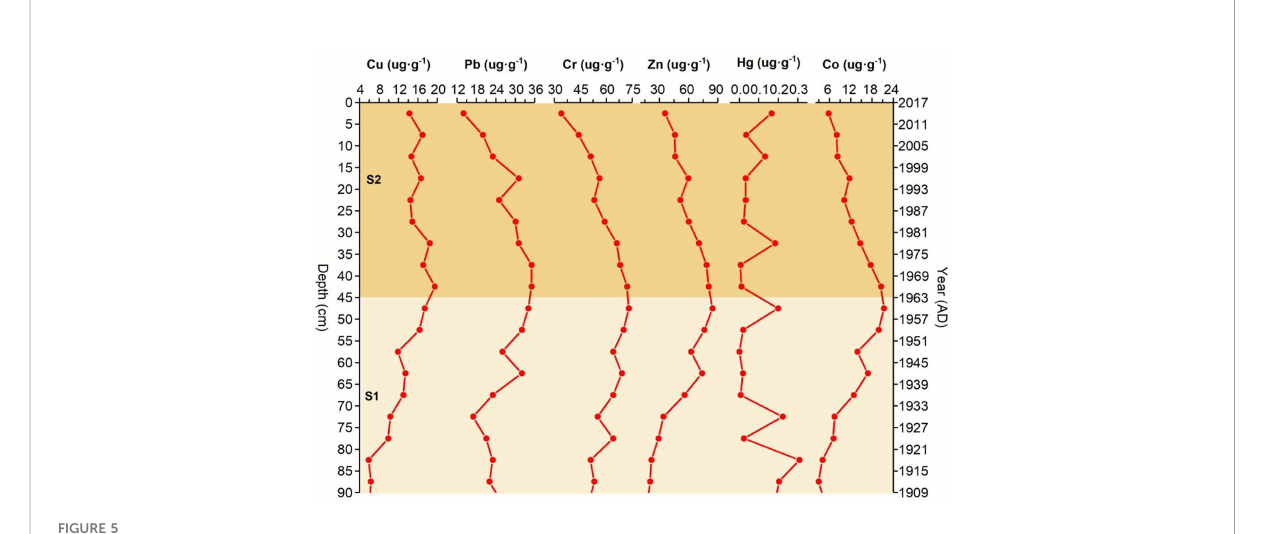
FIGURE 5 Heavy metal deposition sequence of